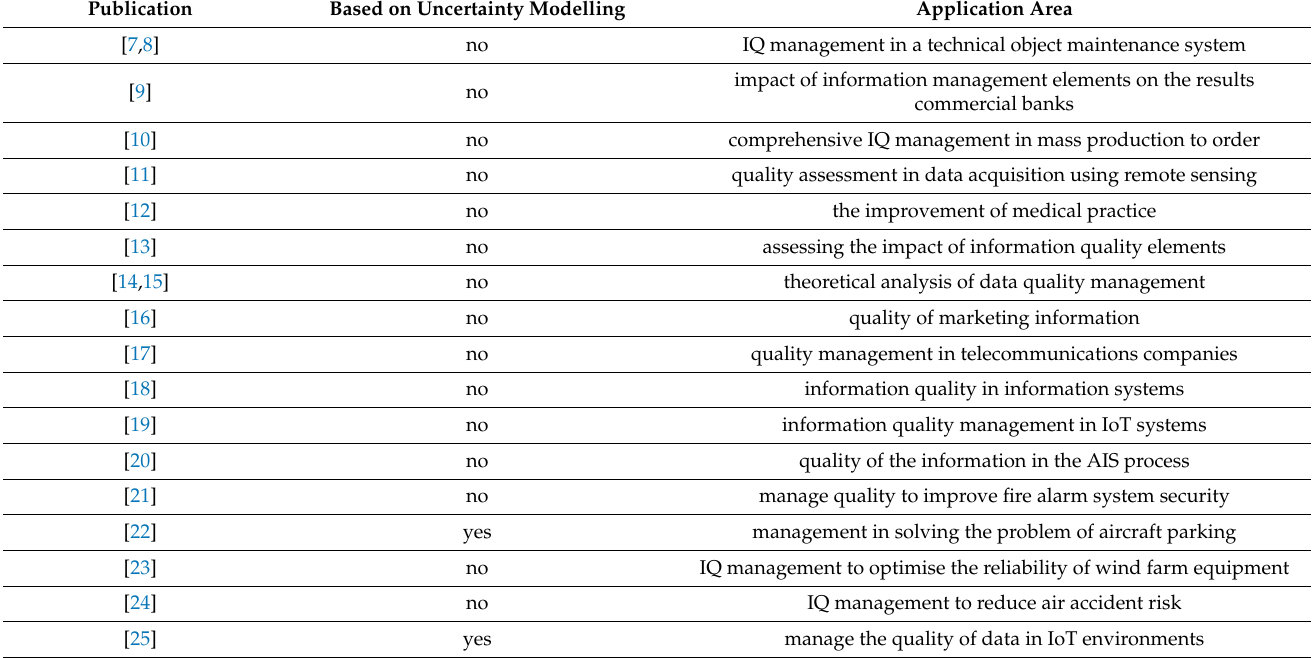
Table 1. Publication comparison summary and its application